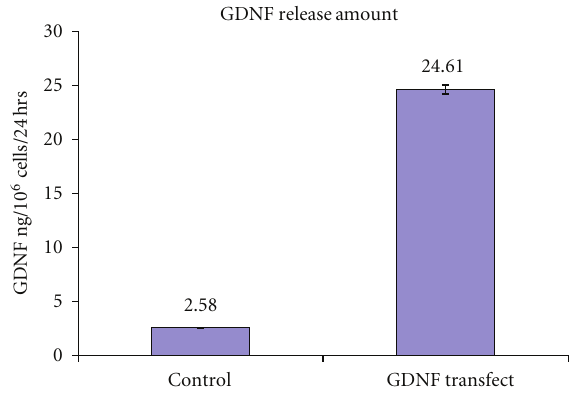
Figure 4: The amount of GDNF produced by nontransfected and transfected cNPCs measured by ELISA. Nontransfected and transfected cNPCs were seeded in UM. Culture media were refreshed 24 hours prior to collection of conditioned media for ELISA. Samples of culture media conditioned by transfected or control cells were analyzed to determine the level of GDNF present. Error bars =